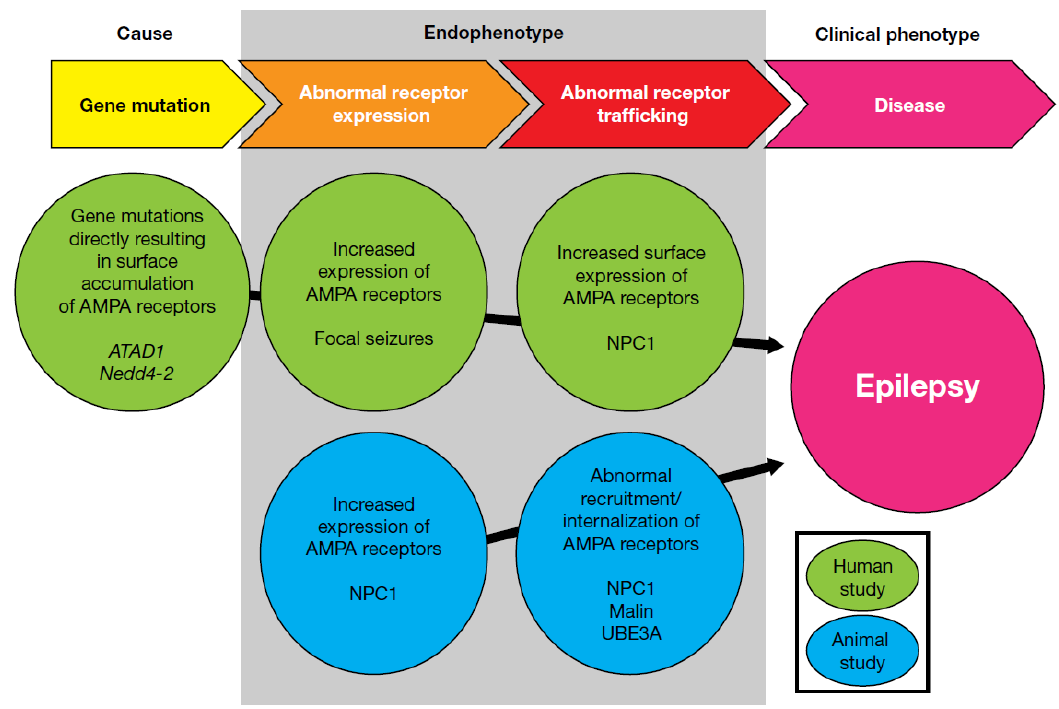
Figure 2. Summary of evidence for AMPA-receptor–related endophenotypes underlying clinical epilepsy. AMPA, α -amino-3-hydroxy-5-methylisoxazole-4-propionic acid.